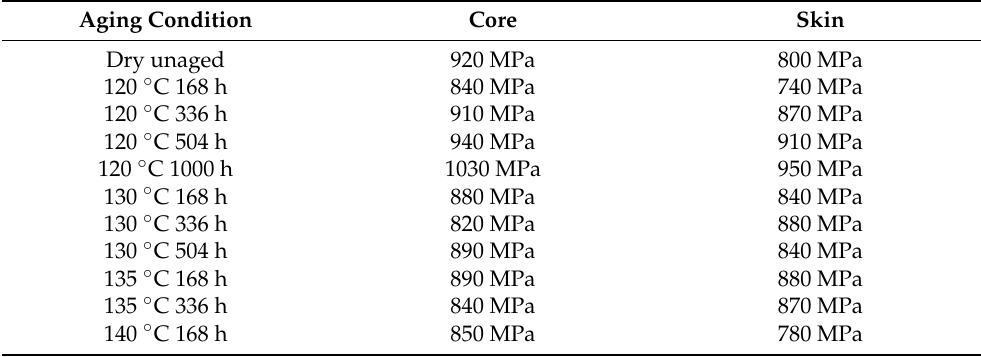
Table 3. Elastic modulus of the aged PA66 end the dry unaged one. Measurements on specimens taken at the core and at the skin of the plaques.